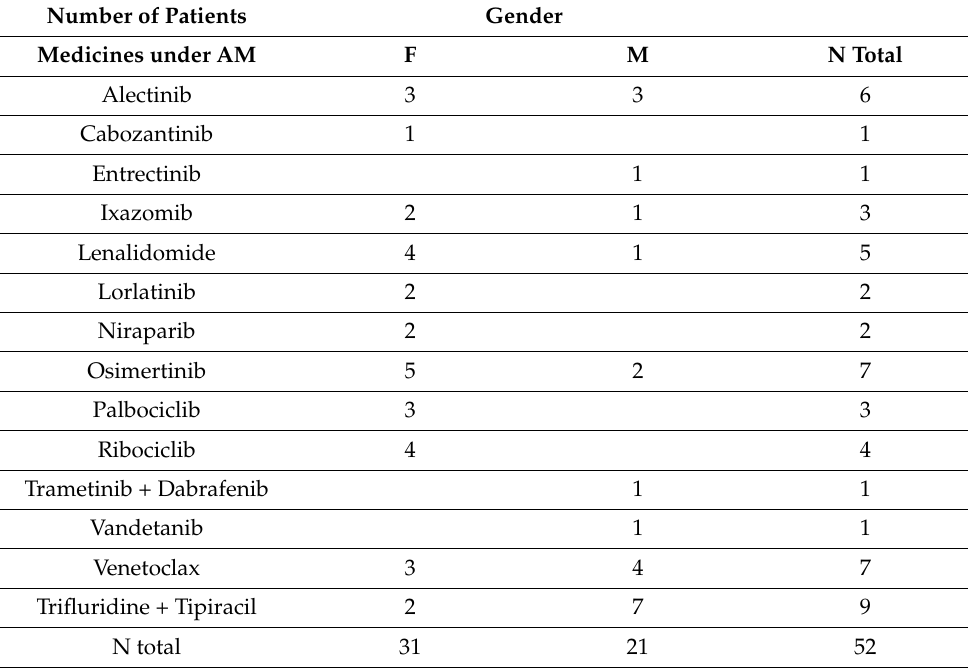
Table 2. Patients categorized by gender and the medicine under AM that was